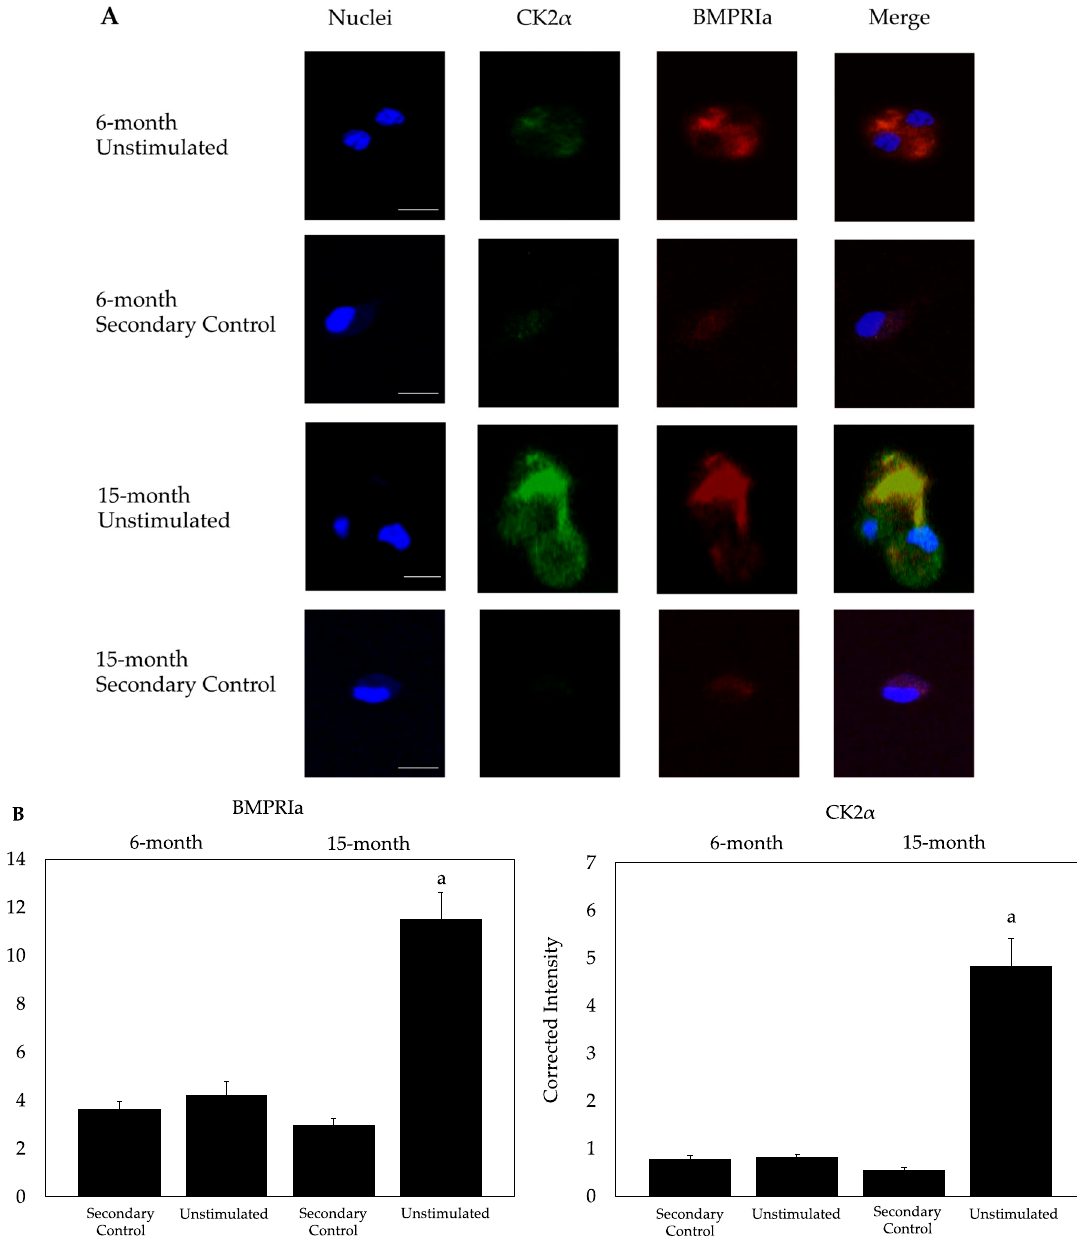
Figure 3. Immunostaining of BMSCs isolated from 6-month-old ( N = 20) and 15-month-old ( N = 20) B6 female mice. ( A ) Cells were plated at a concentration of 1x10 6 cells/mL per well on coverslips in 12-well plates. Confocal microscopic images were obtained at 63x of US and secondary control cells, where the nucleus is stained blue, CK2 α is stained green, and BMPRIa is stained red. ( B ) A semi- quantitative analysis was performed in ImageJ to acquire the intensity of fluorescence. BMSCs isolated from US 15-month-old mice displayed an overexpression of CK2 α and BMPRIa compared to the other groups. At least 10 images were obtained for each experimental group, and the experiment was conducted twice with three technical replicates. The fluorescence was normalized to the secondary control groups, and data were statistically analyzed using the Tukey–Kramer HSD test, where p is set to 0.05 and “a, b, c” lettering denotes statistical significance. Here, letter “a” corresponds to bar 1 (secondary control), letter “b” corresponds to bar 2 (unstimulated), etc. Scale bars are displayed in the nuclei panel and set to 10 µm.